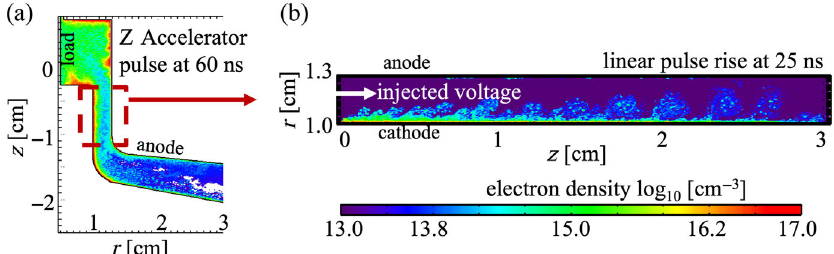
FIG. 1. (a) An example of the inner transmission line on the Z Accelerator (from Ref. [18]) in which electrode plasma formation and plasma influx shunts current across the gap. (b) The simulation geometry for first-principles electrode plasma formation (without plasma influx). The electron density contours are shown for both on the same log 10 scale ( 10 13 – 10 17 ), but the simulation times are not